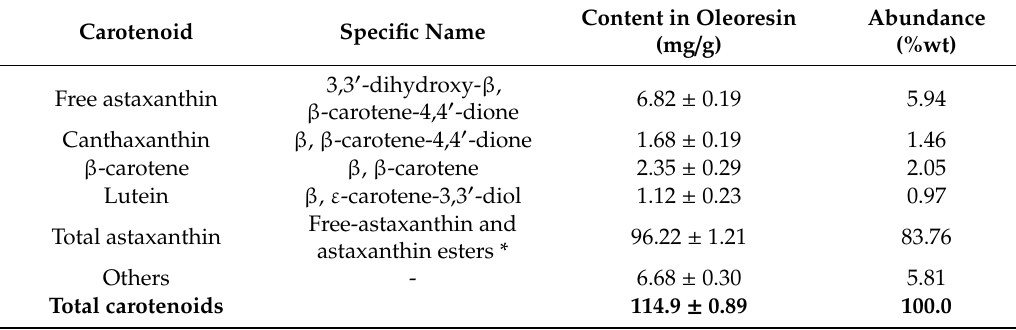
Table 1. Quantification of individual and total carotenoids in oleoresin extracted by the SC-CO 2 method from the microalga Haematococcus pluvialis using analytical method and HPLC. The results were expressed as mg of carotenoids / g oleoresin and as the relative abundance of total carotenoid (%wt) ( ± SD, n = 3). Content in Oleoresin Abundance Carotenoid Specific Name (mg / g) (%wt) 3,3 (cid:48) -dihydroxy- β , Free astaxanthin β , β -carotene-4,4 (cid:48)